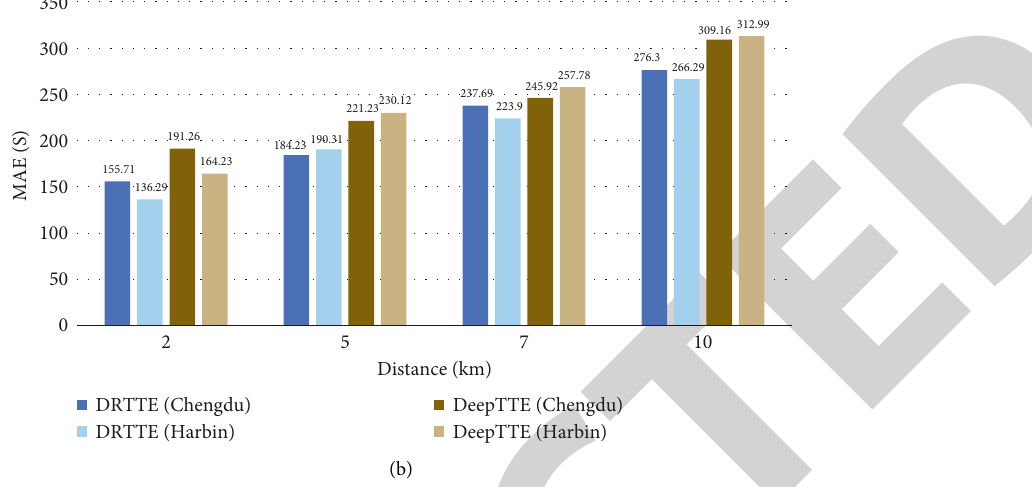
Figure 10: Impacts of the travel